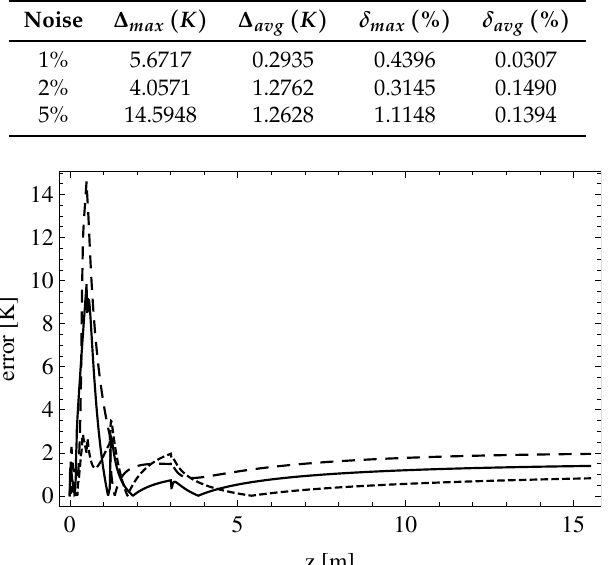
Table 6. Errors of temperature reconstruction in the control points obtained for measurements read at every 0.01m (two steps optimization).